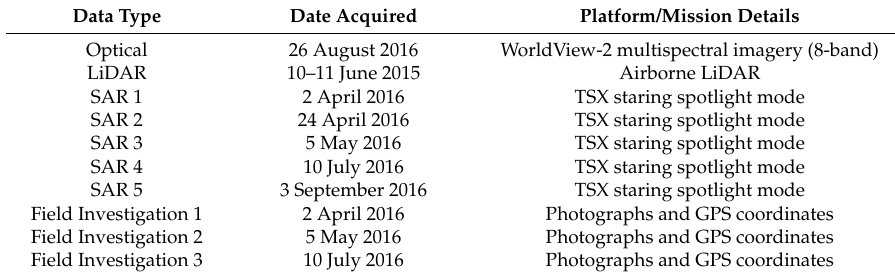
Table 1. Summary of TSX, airborne LiDAR and satellite-based optical imagery data used in this study.